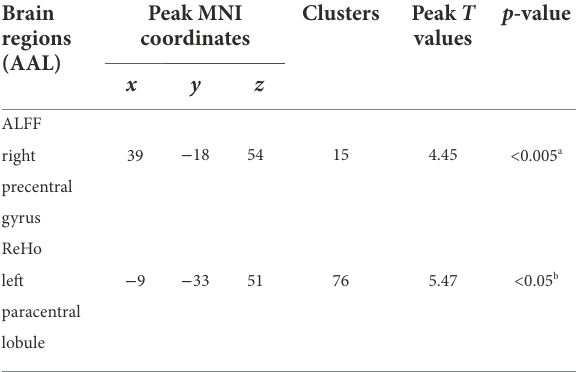
TABLE 2 Increased ALFF and ReHo values of male rowing athletes after